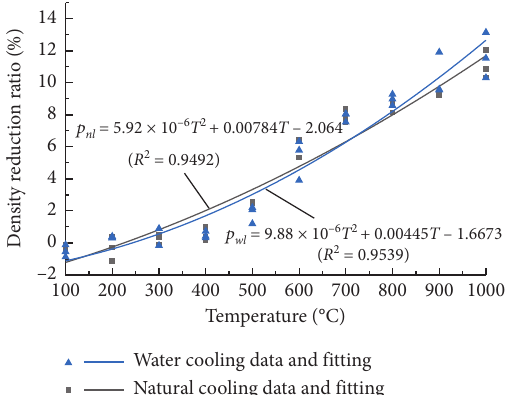
Figure 6: P-wave velocity of high temperature sandstone after two cooling